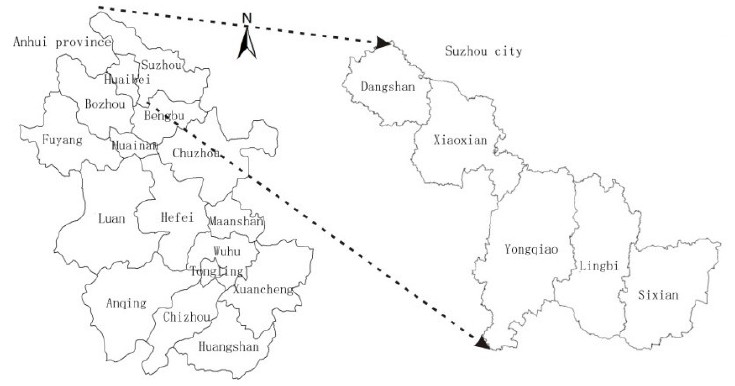
Figure 1. The geographical location of Suzhou City.